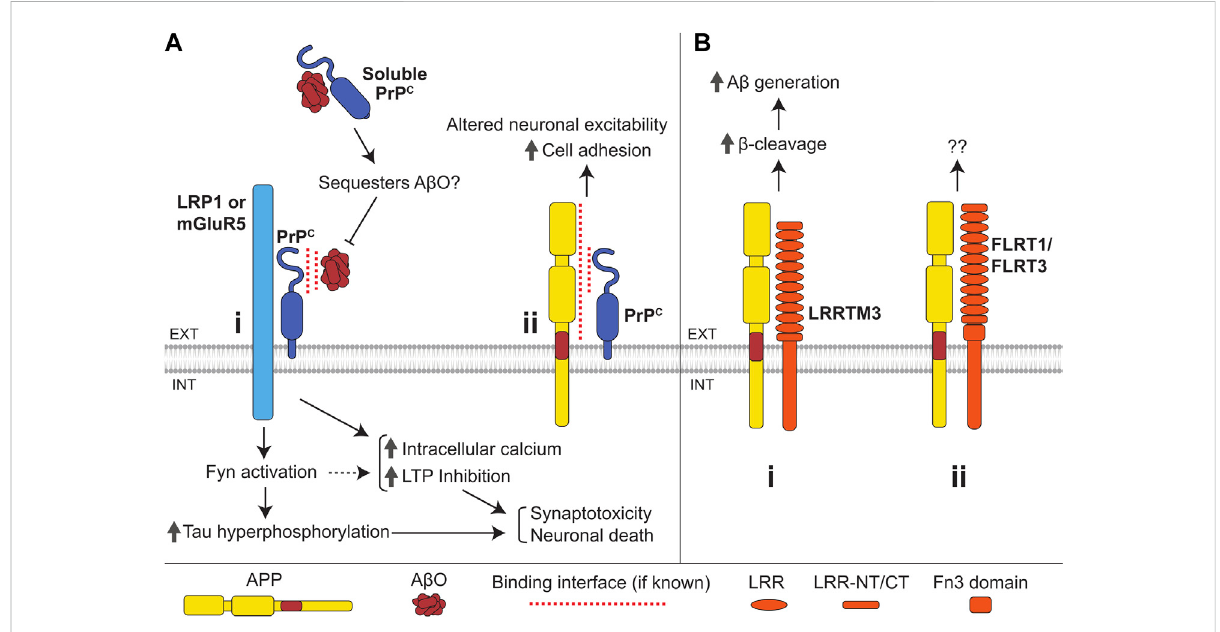
FIGURE 7 Interactions ofthe cellular prionprotein(PrP c )and LRR superfamilyCAMs with APP and A β . (A) (i) Binding of A β Os to PrP c inducesan increasein intracellularCa 2+ levels, LTP inhibition, Fynactivation, andtau hyperphosphorylation, ultimately resulting insynaptotoxicity and neuronal death. PrP c isanchoredtotheouterlea fl etoftheplasmamembraneandtransmitstheA β O-inducedsignalsacrosstheplasmamembranebyinteractingwiththe transmembrane proteins LRP1 and mGluR5. Soluble PrP c binds to and can sequester A β Os, preventing membrane-bound PrP c -mediated A β O toxicity. (ii) Interaction of APP with the N-terminal domain of PrP c enhances cell adhesion via an unknown mechanism and may also regulate neuronal excitability. (B) (i) LRRTM3 interacts with APP promoting its β -cleavage and facilitating A β generation. (ii) APP also interacts with FLRT1 and FLRT3, with unknown